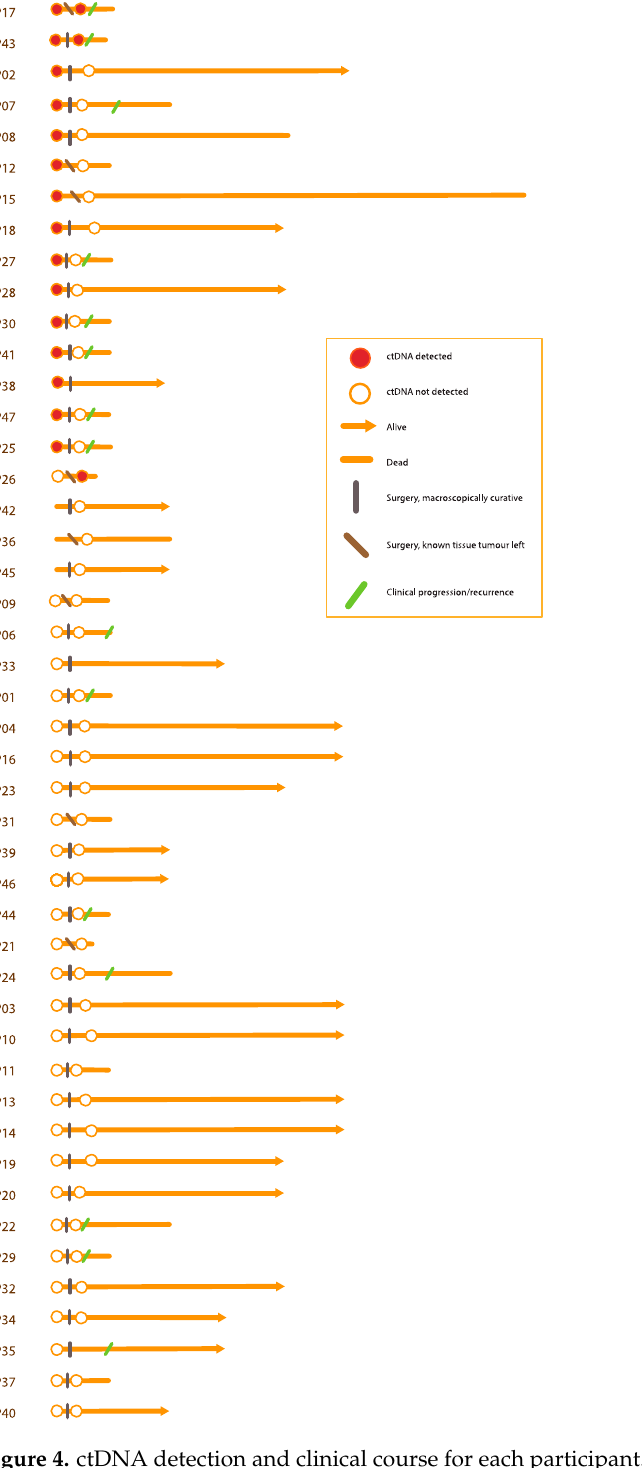
Figure 4. ctDNA detection and clinical course for each participant. Each participant is represented by an orange lifeline, starting with the diagnostic plasma sample. The x -axis represents time from diagnosis. The detection status of ctDNA for each participant is represented by a circle, and partic- ipants still alive at the end of the study have a lifeline ending with an arrow. Time of surgery and recurrence are marked by vertical lines, as shown in the orange box on the right. For the specific variants detected and their variant allele frequencies, please refer to Table S7. ctDNA, cell-free tumour